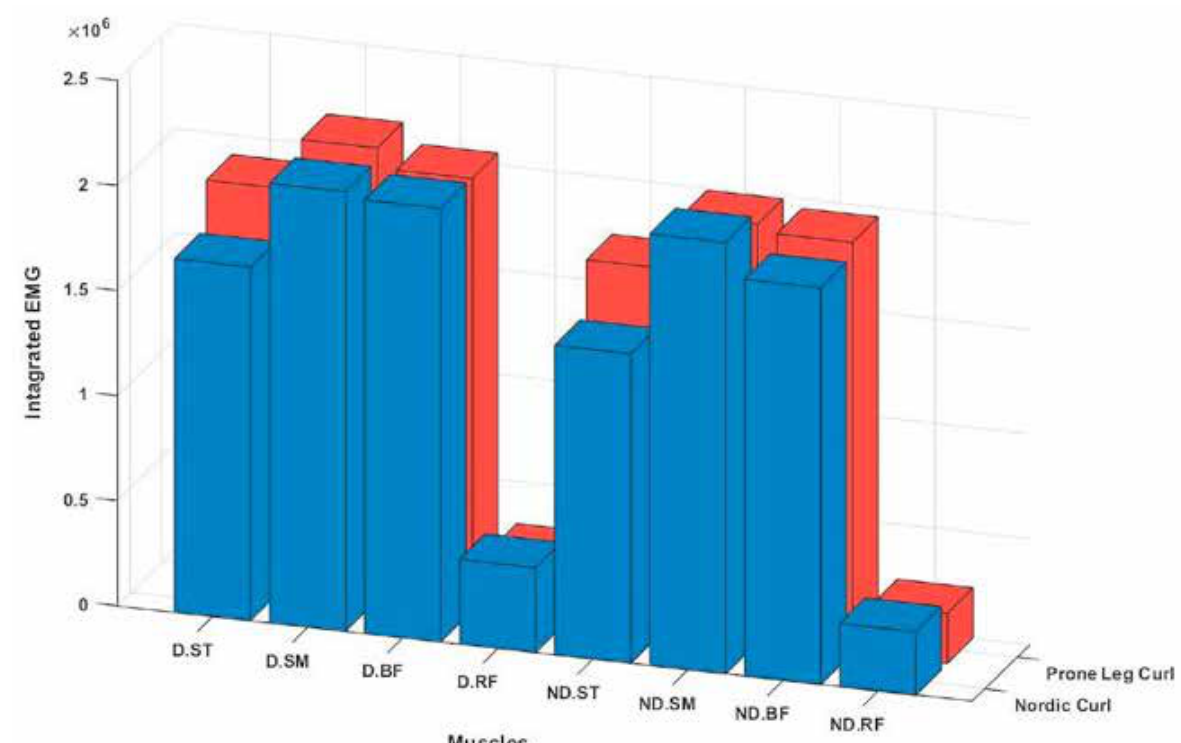
Figure 6. Comparison of Cumulative Integrated EMG Values of Each Muscle During PLC and NC Exercises: D.ST: Dominant semitendinosus, D.SM: Dominant semimembranosus, D.BF: Dominant Biceps femoris, D.RF: Dominant rectus femoris, ND.ST: Nondominant semitendinosus, ND.SM: Nondominant semimembranosus, ND.BF: Nondominant bicepsfemoris, ND.RF: Nondominant rectus femoris.